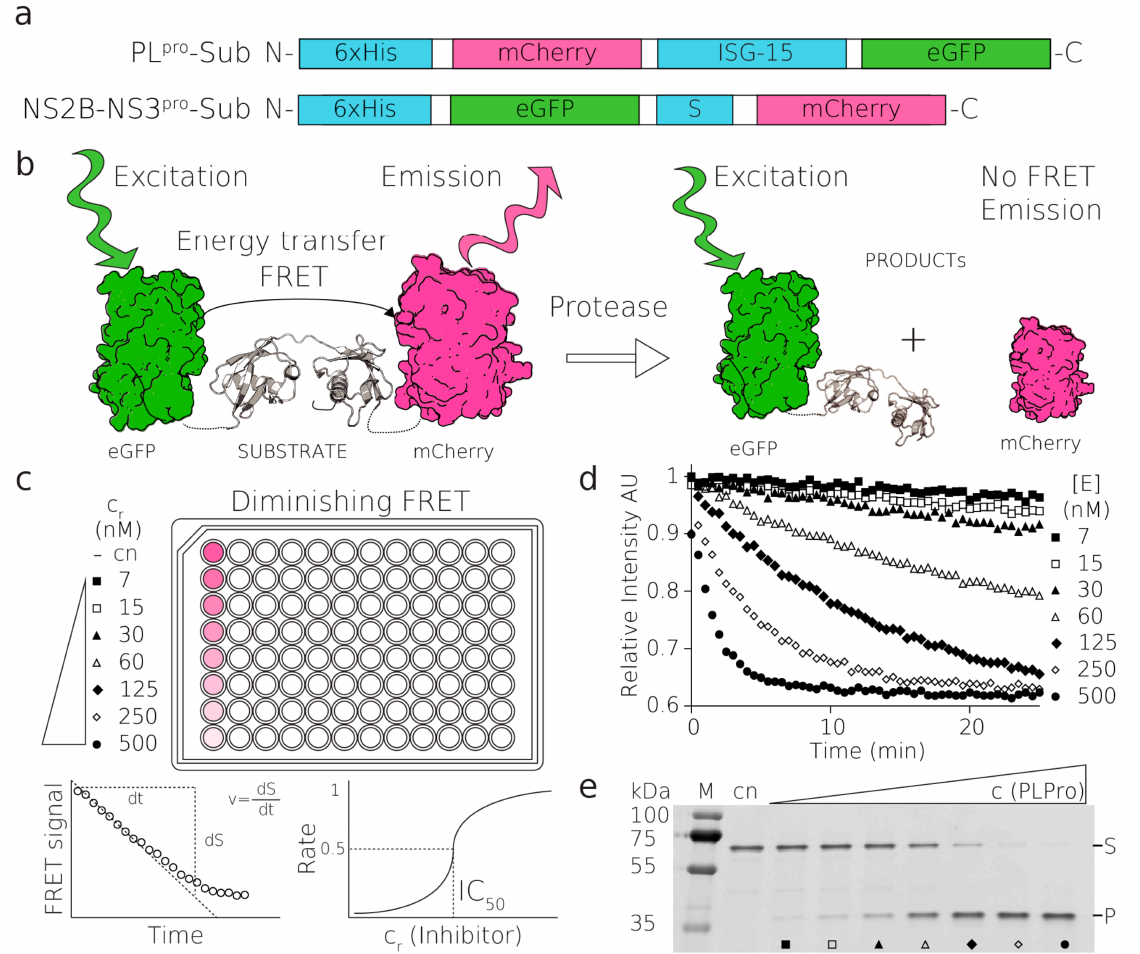
Figure 1. Substrates, principles of FRET assay. ( a ) The fluorescent PL pro and NS2B-NS3 pro substrates, ( b ) schematics of the FRET-based proteolytic assay, eGFP is excited with a green light at 488 nm, FRET transfers the excitation to mCherry which emits the light that is detected. After proteolytic cleavage, this FRET signal is abolished, ( c , d ) the reaction of PL pro substrate with a serial dilution of PL pro enzyme (500–7 nM), ( c ) schematics of reactions followed in the fluorescent plate reader, ( d ) these reactions were loaded on SDS-PAGE gel and visualized on a fluorescent scanner ( e ), where (S) and (P) donate substrate and product bands and full-length gel are shown in Figure